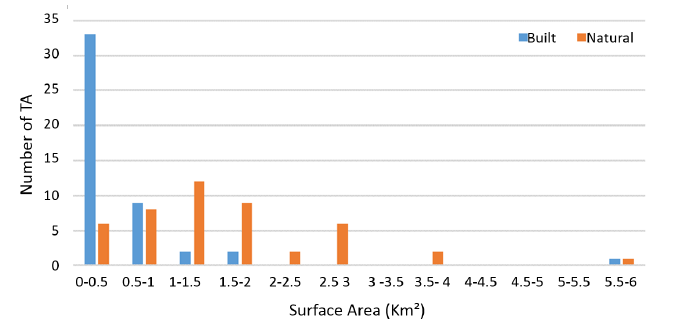
Figure 3. Number of TA sets according to surface area (km 2